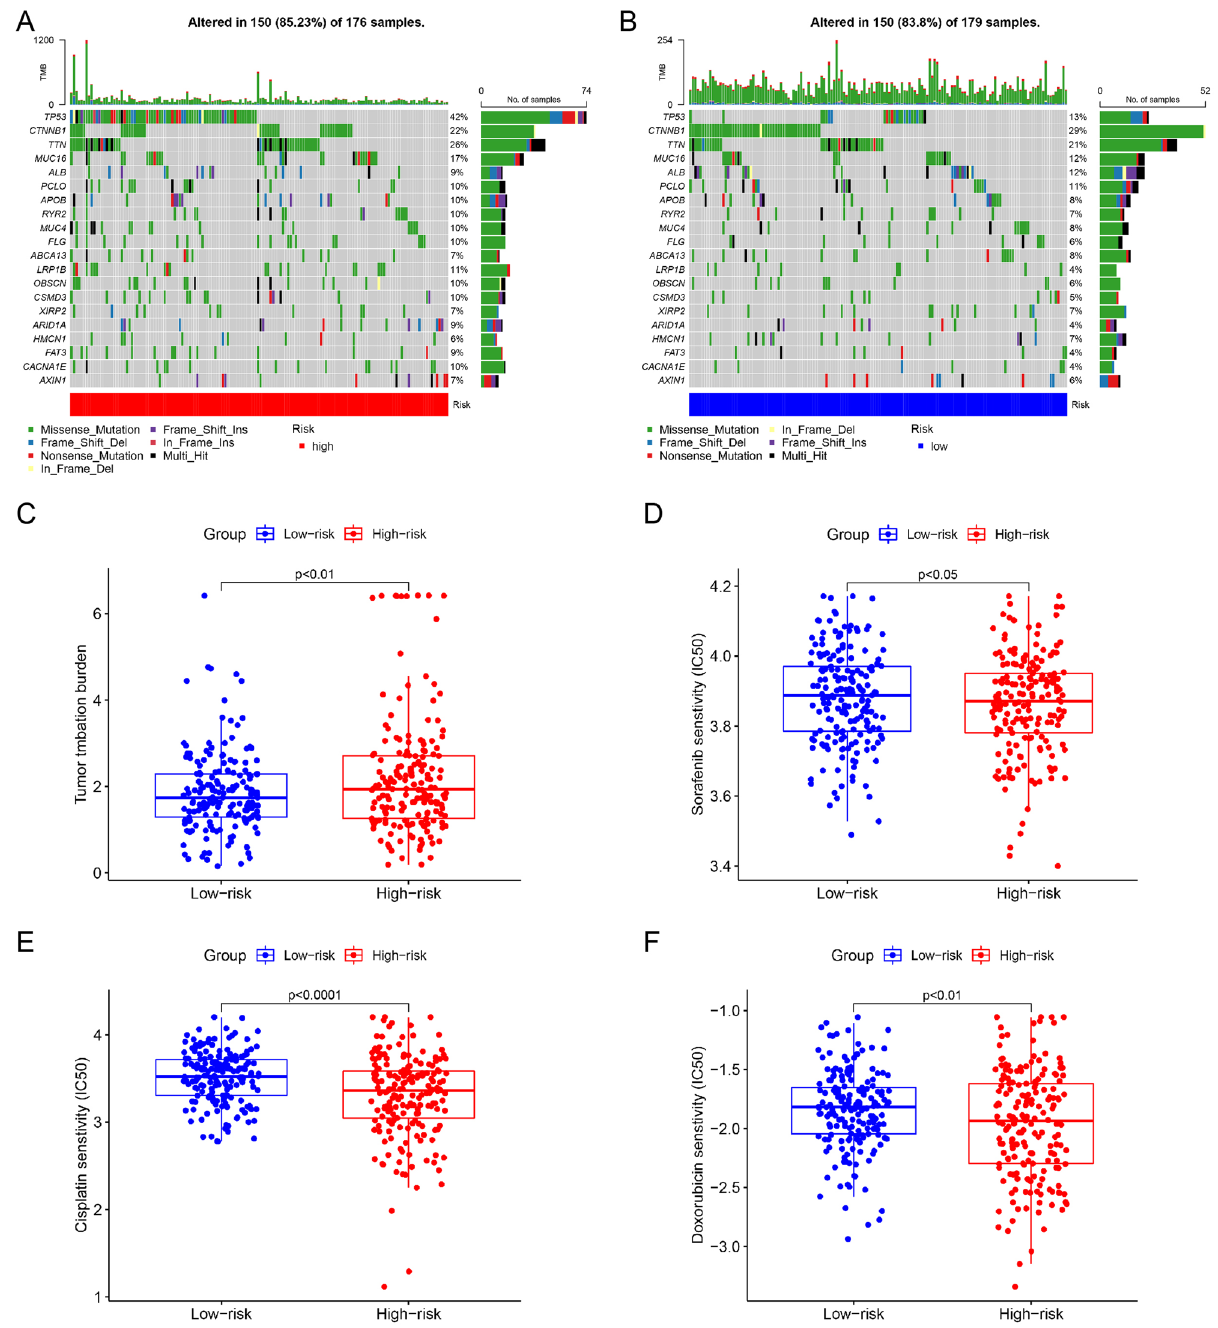
doxorubicin based on risk